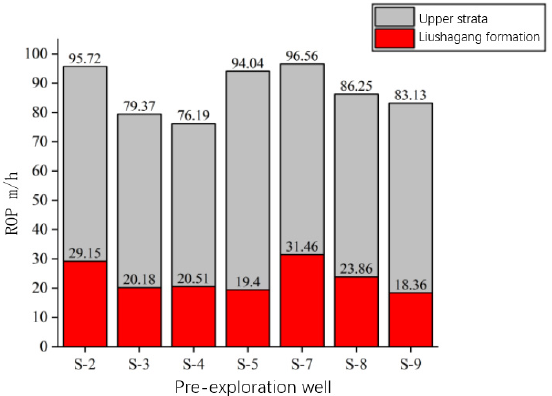
Figure 1. Statistic diagram of drilling speed of exploratory well.